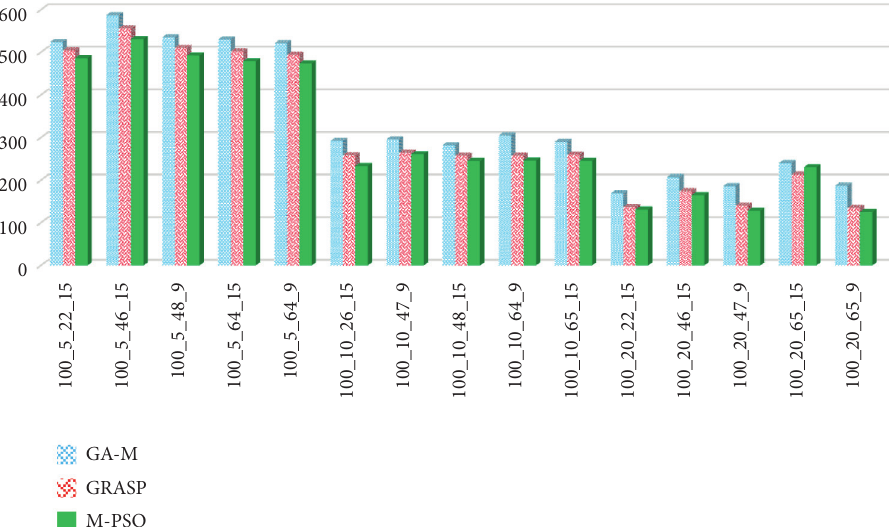
Figure 7: Comparing AVG values between GA-M, GRASP, and M-PSO of 100 tasks